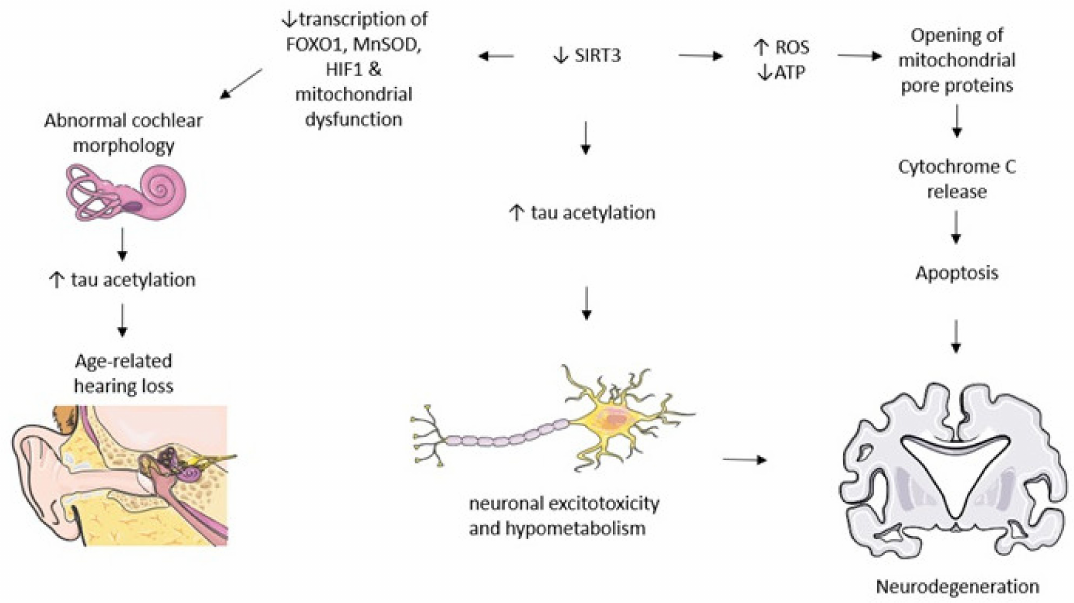
Figure 2. SIRT3 modulates signaling pathways relevant to neurodegenerative pathology. Decreases in SIRT3 lead to multiple physiopathological modifications that culminate with neuronal dysfunction. Abbreviations: ↑ increases, ↓